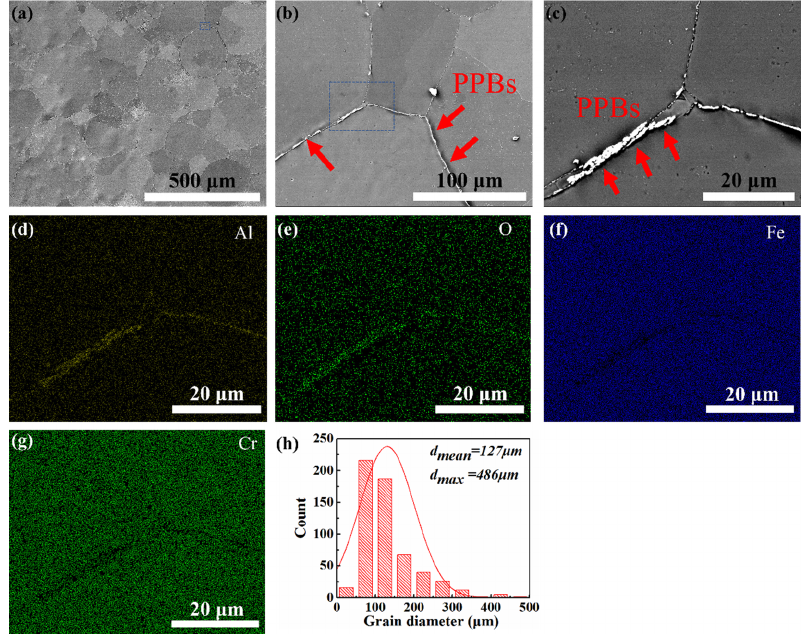
Figure 3. SEM secondary electron images of ( a ) the macro and ( b , c ) continuous precipitates for the as-HIPed sample; ( d – g ) EDS map of continuous Al 2 O 3 precipitates along the grain boundaries in ( c ) for the as-HIPed alloy; ( h ) distribution of grain diameter of the steel.